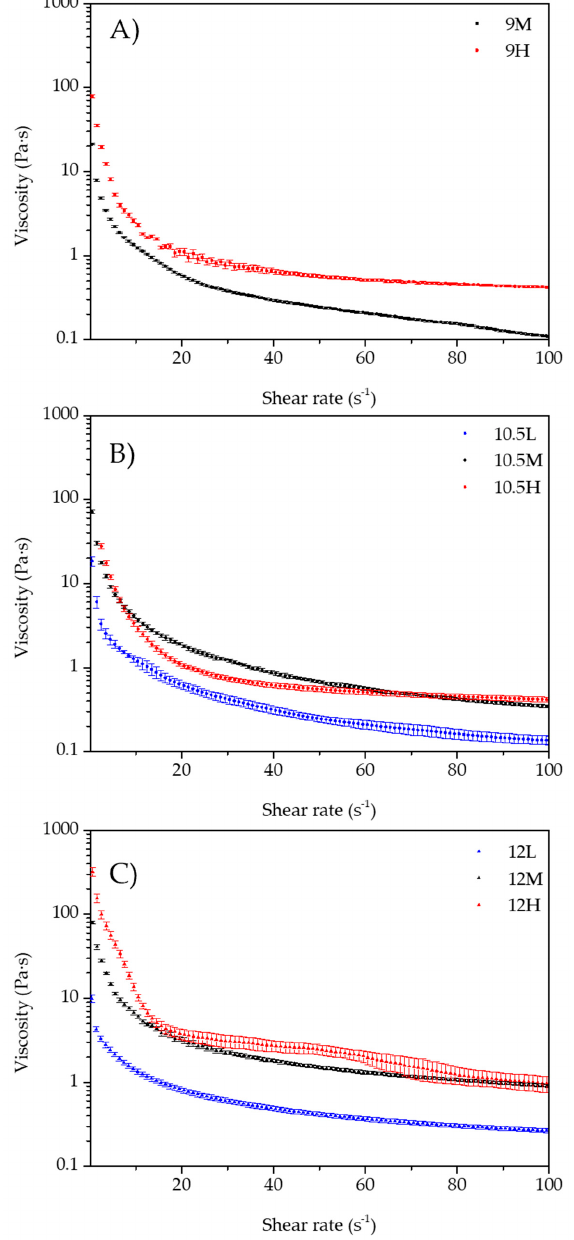
Figure 3. Flow curves of the emulsions. ( A ) 9M and 9H; ( B ) 10.5L, 10.5M, and 10.5H; ( C ) 12L, 12M, and 12H.